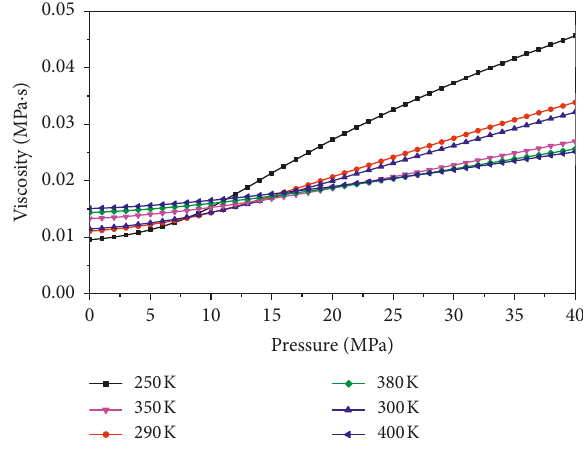
Figure 6: Viscosity of methane. Table 1: Division of flow regimes according to the Knudsen